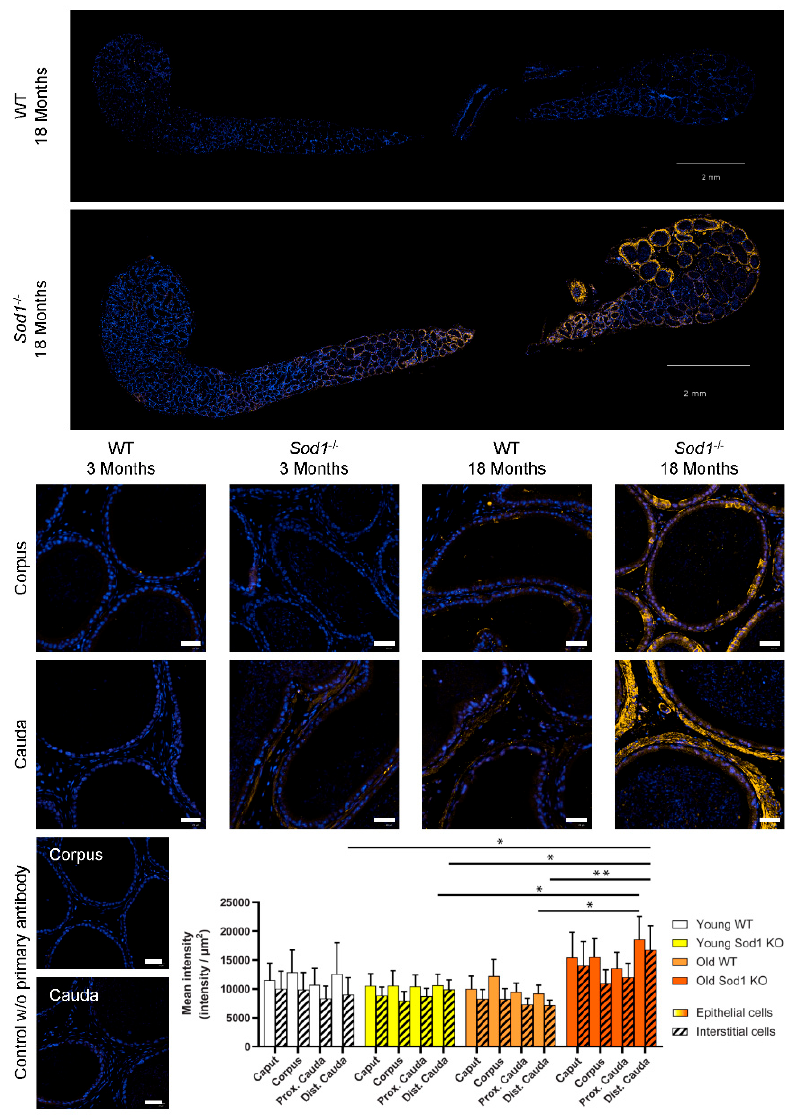
Figure 3. Lipid peroxidation as assessed by 4-HNE immunostaining is increased in the corpus and cauda epididymides with aging and this phenotype is enhanced in the absence of SOD1 expression. Representative pictures of whole epididymis sections of 18-month-old wild-type and Sod1 − / − mice after the immunostaining of the 4-HNE (yellow) and the counterstaining of the nucleus (DAPI, blue). Scale bar: 2 mm. Observations have been carried out in epididymis sections of 3-month-old and 18-month-old wildtype and Sod1 − / − mice. Staining was strongest in the corpus and cauda epididymides on the apical membrane of epithelial cells (arrow) and on intracellular membranes (arrow head). The negative controls (no primary antibody) for immunostaining are displayed for the corpus and cauda epididymides. Scale bar: 40 µ m. The 4-HNE staining has been quantified in the epididymal epithelium (clear histograms) and in the interstitial tissue (dashed histograms) separately. * p < 0.05; ** p < 0.01 (3-way ANOVA, n = 4–5).